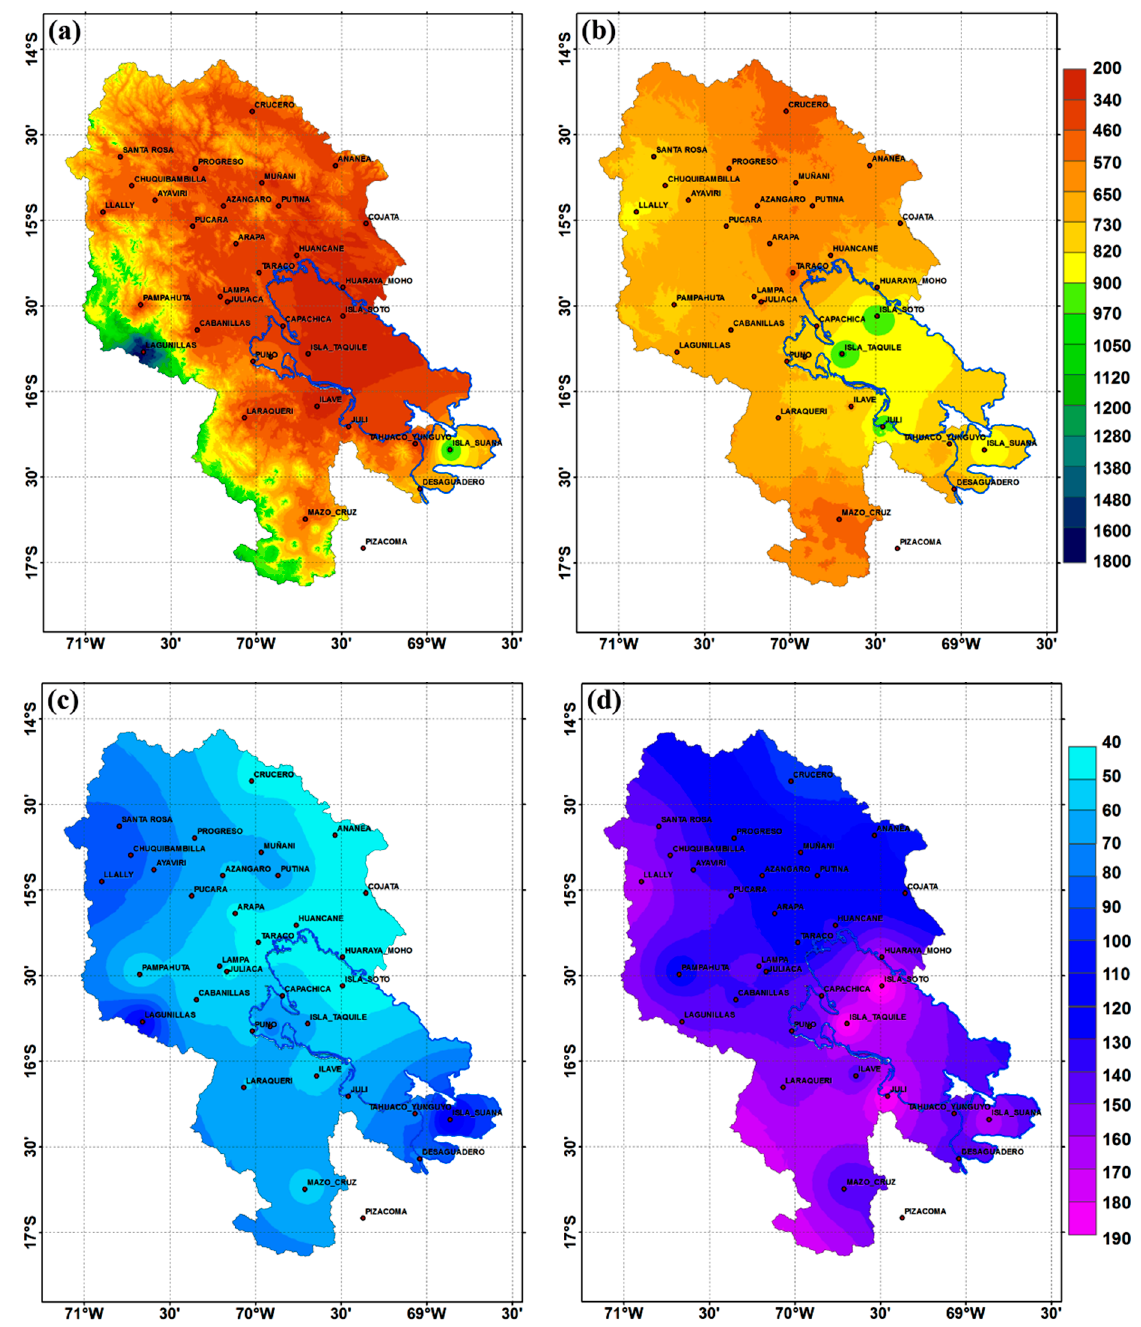
Figure 6. Spatial distribution of the annual and summer season precipitation (2002–2013): ( a ) CMORPH, ( b ) observed data for the summer precipitation (DJF), ( c ) CMORPH, and ( d ) observed data. The scale in colors represents the precipitation in millimeters (mm). Vertical axis indicates the latitudes, and the horizontal axis refers to the lengths, both in degrees (°).